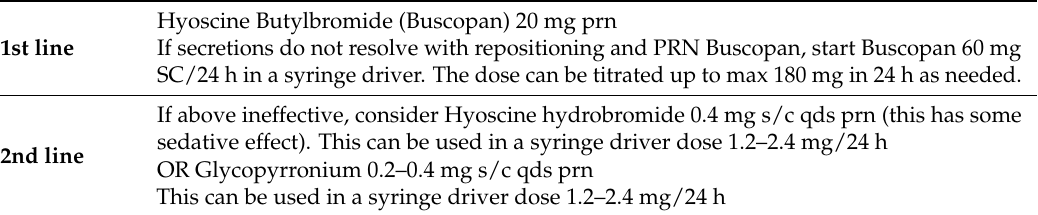
Table 4. Medications to manage respiratory